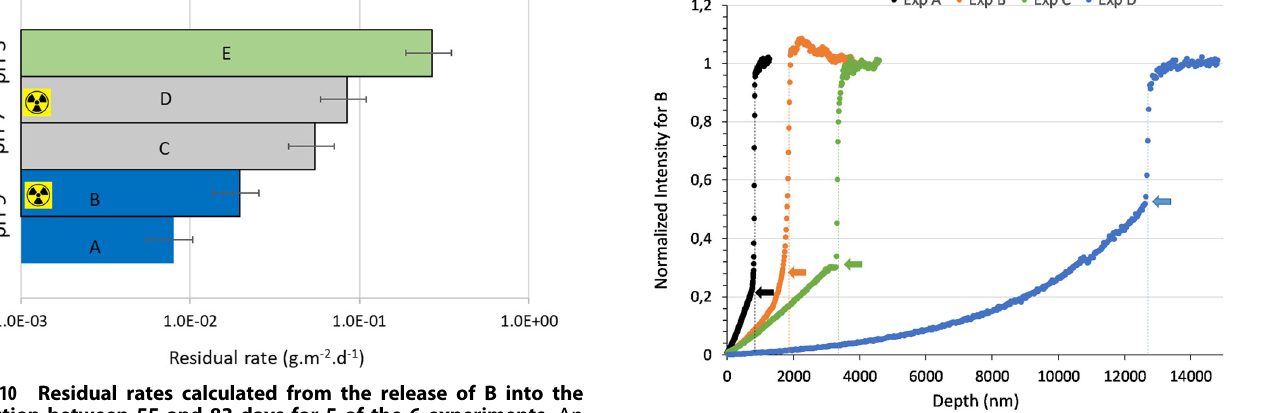
Fig. 11 ToF-SIMS B pro fi les for experiments A – D. The dotted vertical lines indicate the position of the pristine glass/alteration layer interface, and the arrows show the B content at that interface. The retention of B in the alteration layer increased with the thickness of the altered glass.